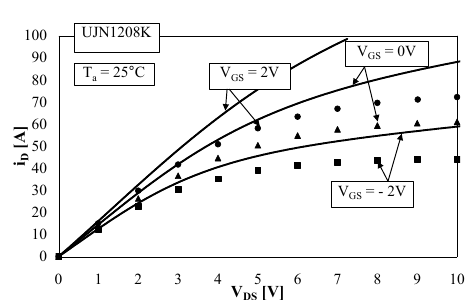
Fig. 1. Calculated and measured output characteristics of the transistor UJN1208K at 25°C